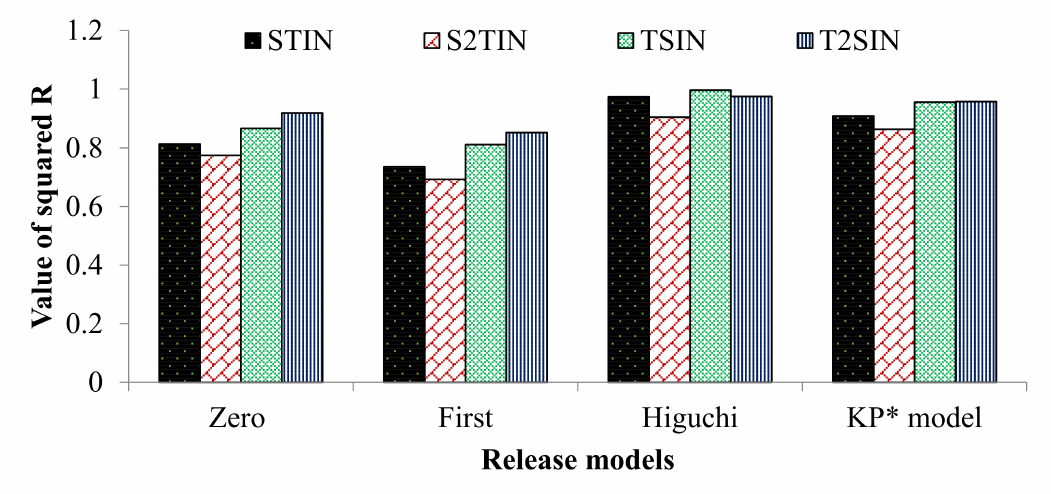
Figure 5. Correlation coefficient (R 2 ) values for the IMA release from different NANIMA formulations (*